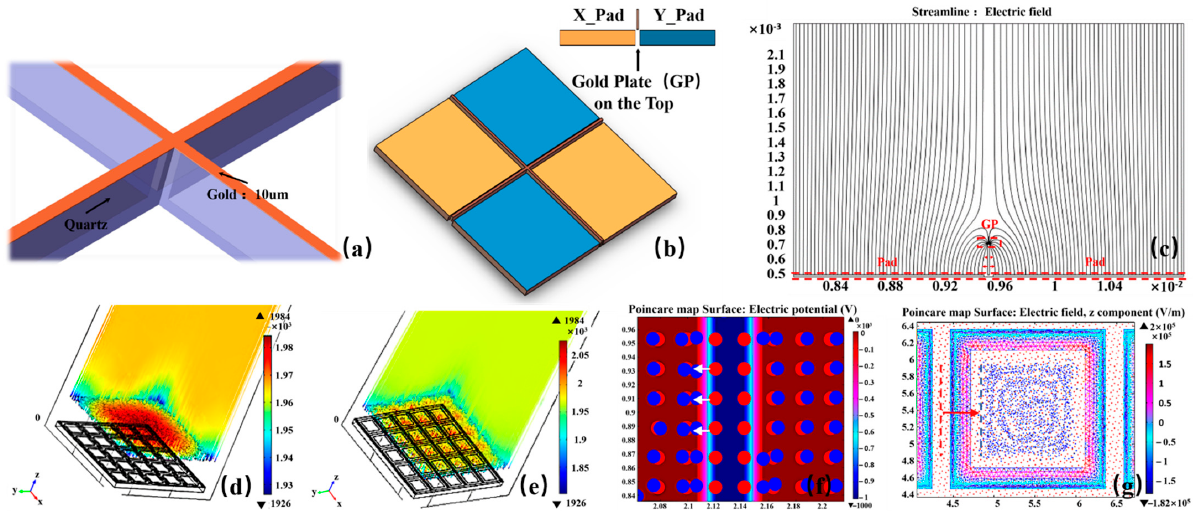
Figure 2. Design and simulation for cells of the detector. ( a ) is a part of a deflector. ( b ) is a square cell with a deflector. ( c ) is the electric field distribution after loading bias voltage on the gold plate of the deflector. The particles at the top are expected to be deflected by the electric field and eventually fall onto the detector pads. ( d , e ) are the particle distribution maps at 24 ns and 24.6 ns after the release, respectively. In ( f , g ), the blue dots are the particle locations where the particles follow the electric field lines and drift to the surface of the bottom detector pads and the red dots are the particle locations of the initial release at the top. In ( f ), it can be seen that the electrons at the top are collected at the edge of the detector pads due to the deflected electric field generated by the shielding plate. ( g ) shows the collection effect after the optimization of the structure and electric